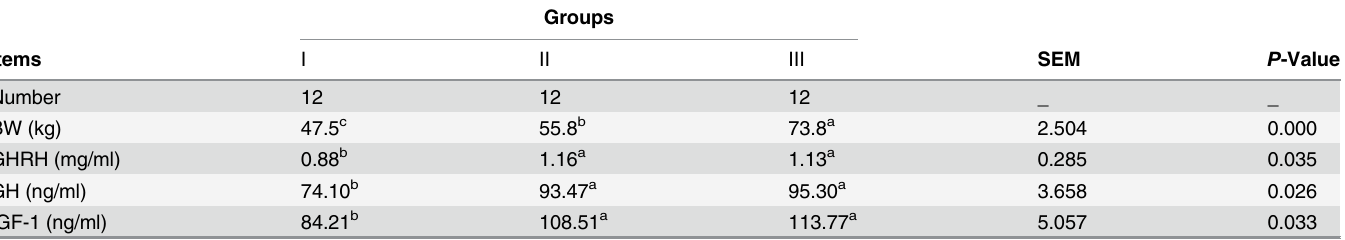
Table 2. Comparison of body weight and somatotropic axis hormones in yaks from different groups.